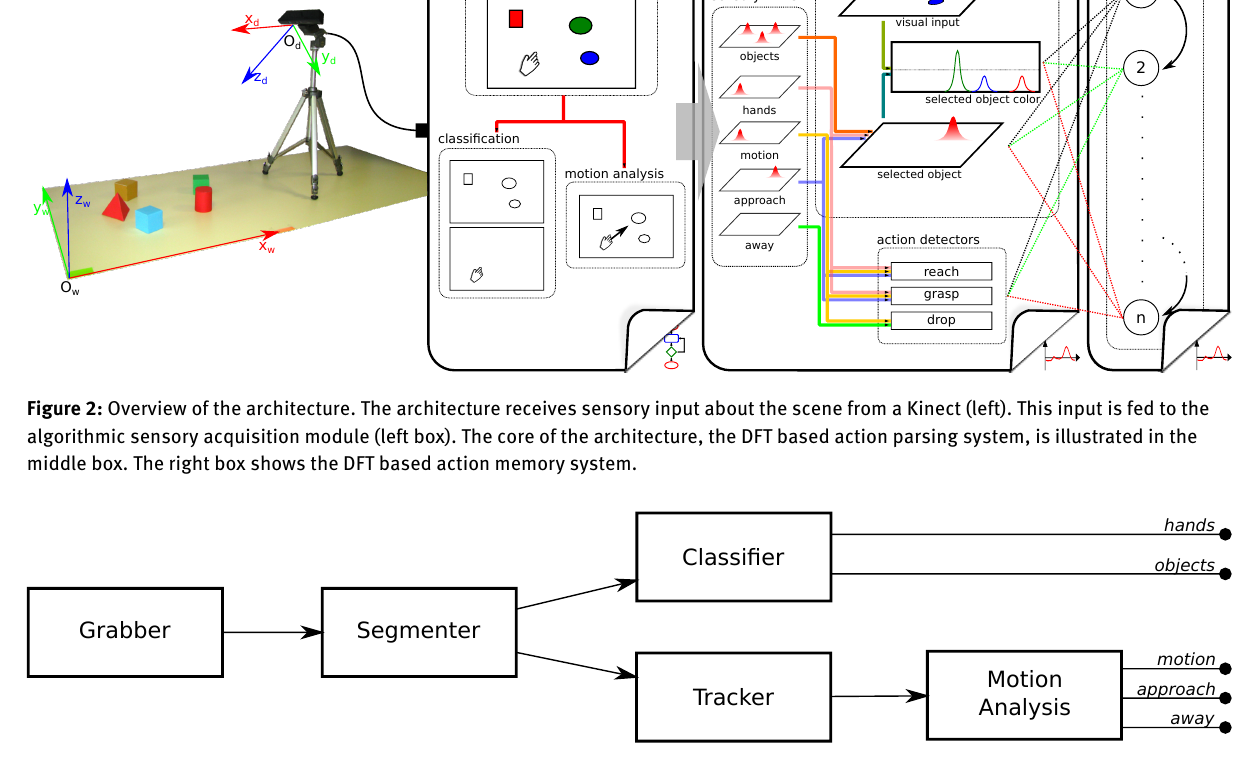
Figure 3: Sensory acquisition module